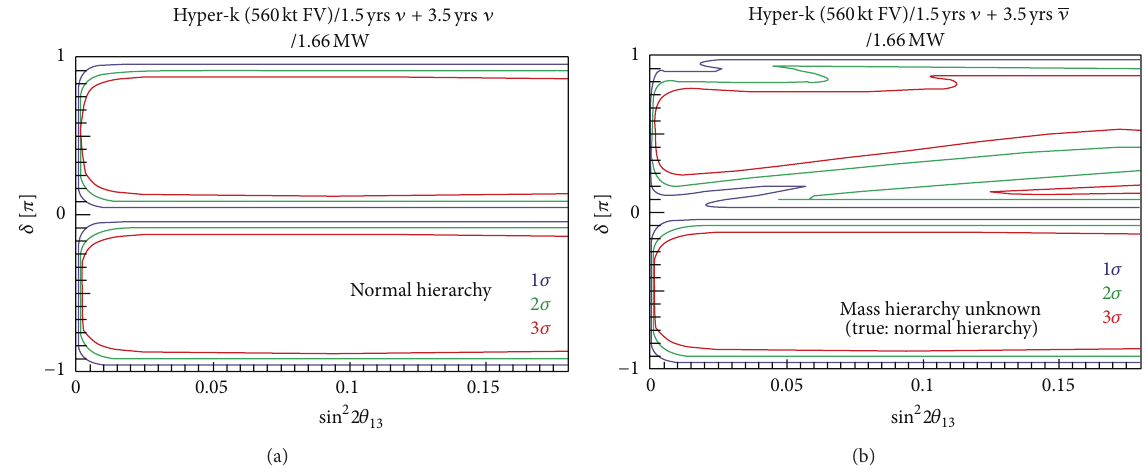
Figure 14: T2HK sensitivity to CP violation at 1, 2, and 3𝜎 as a function of sin 2 2𝜃 13 . The mass hierarchy is assumed known (a) or not (b). Figure is taken from